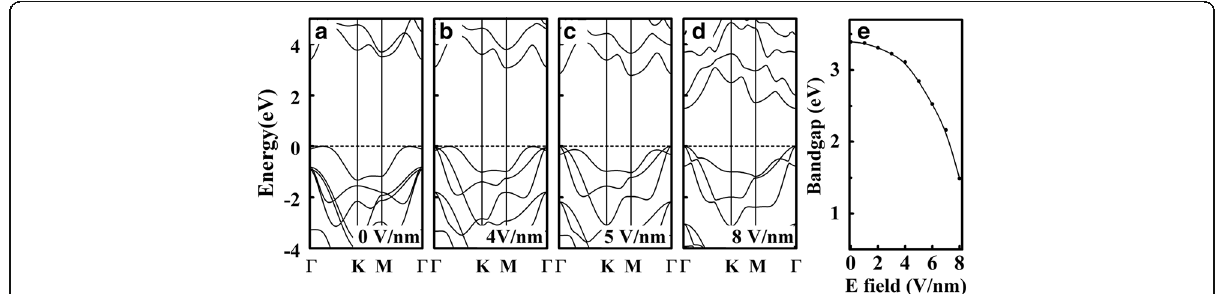
Fig. 3 Band structure of GaS ML a without an external electric field and b – d with an external electric field of 4, 5, and 8 V/nm, respectively. The dashed lines indicate the Fermi levels, which are set to zero. e Variation of the energy gap with the external electric field for GaS